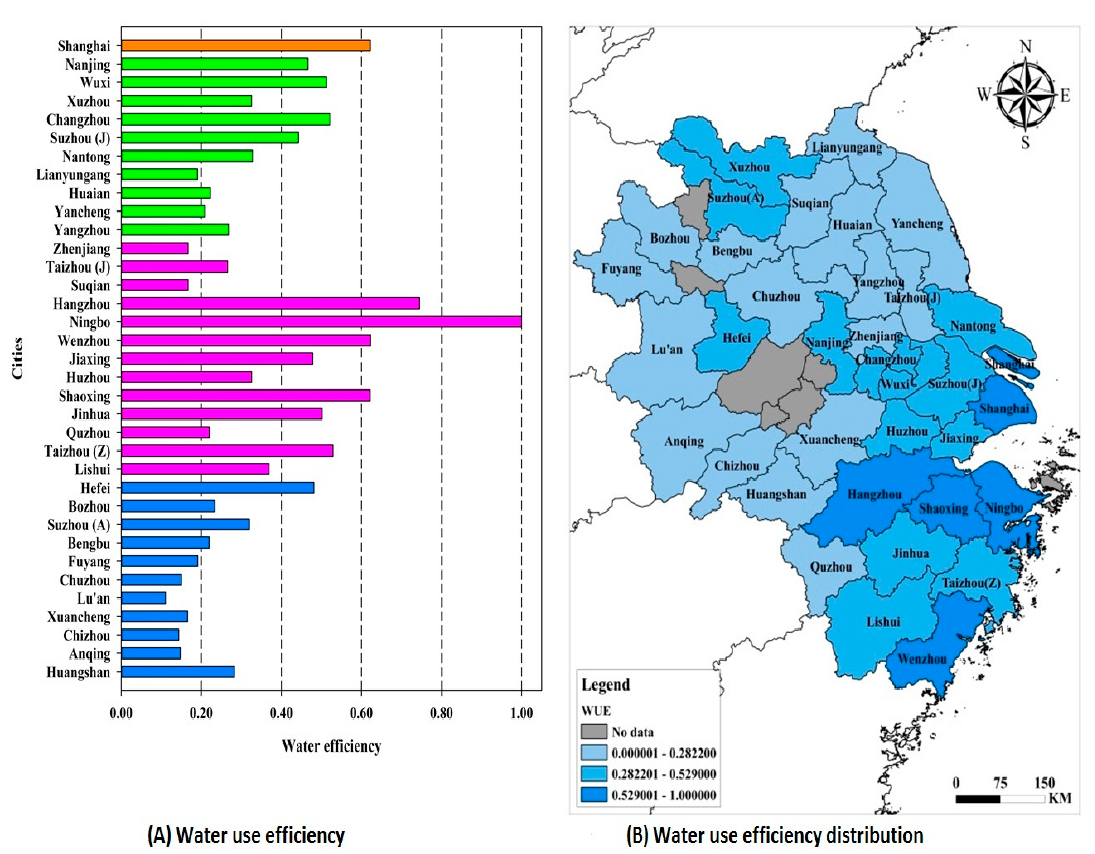
Figure 3. Water use efficiency ( A ) and distribution ( B ).